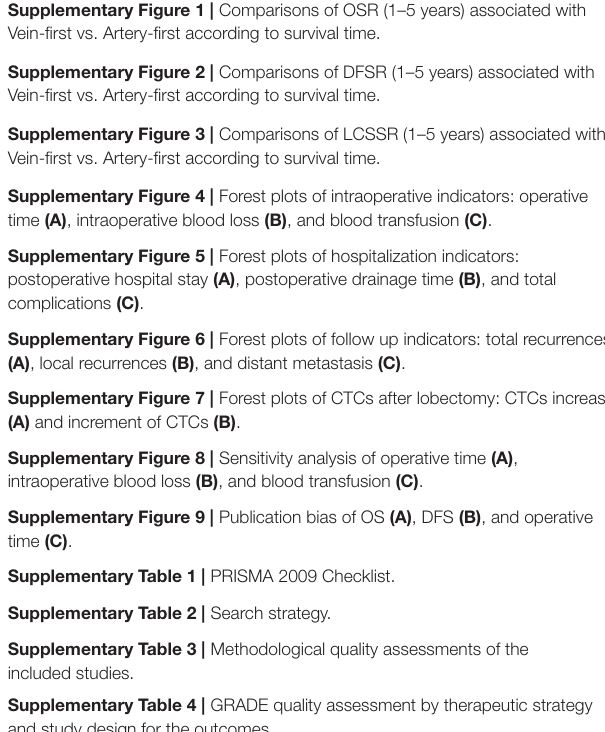
Supplementary Table 1 | PRISMA 2009 Checklist. Supplementary Table 2 | Search